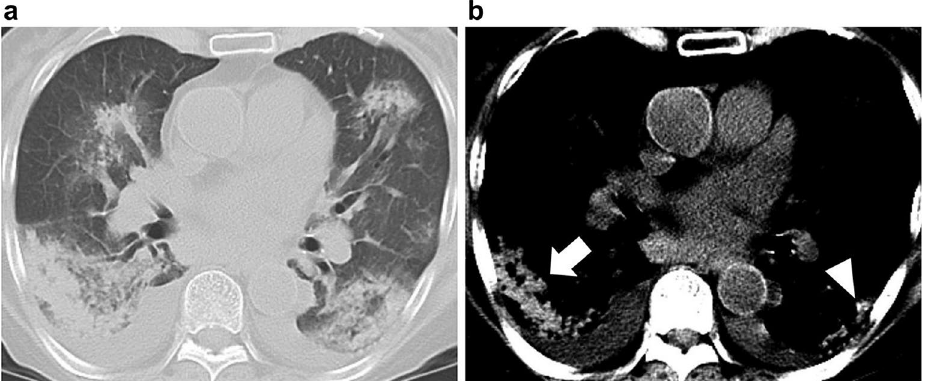
Figure 2. 78-year-old woman with diffuse alveolar hemorrhage in Sjögren’s syndrome. ( a ) Transaxial CT with a lung window setting (window level = − 600 HU, width = 1600 HU) showing consolidations in both lungs. ( b ) In this study, the high-density area in the right lung, which is obviously higher than that of the aorta in the narrow window setting (window level = 35 HU, width = 80 HU), is interpreted as the hyperdense consolidation sign (arrow). On the other hand, the small nodular high-density lesion in the left lung, which can be confused with calcification or artifacts, is interpreted as NOT showing the hyperdense consolidation sign (arrowhead).